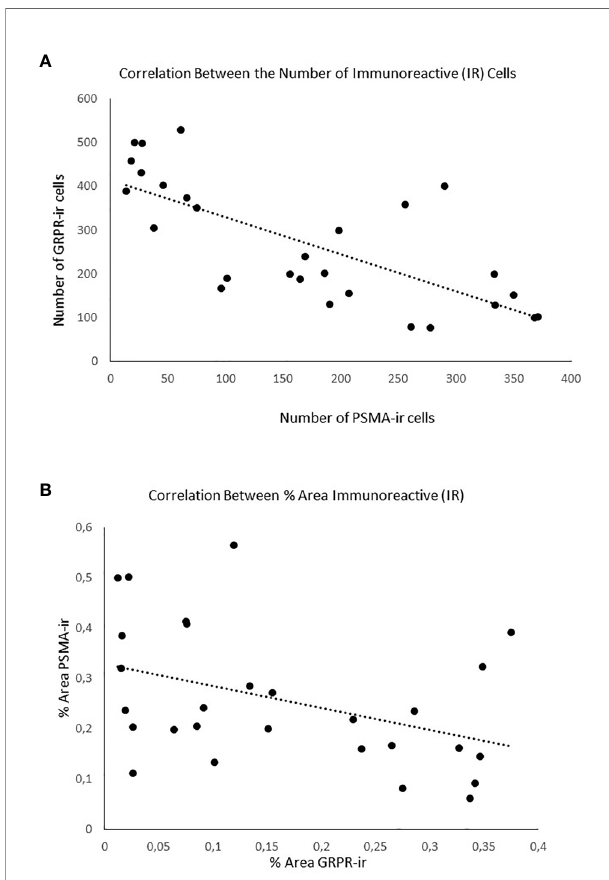
FIGURE 3 | Relationship between tumor grade, using Gleason scores, and expression of PSMA and GRPR. (A) the number of GRPR cells expressed (immunoreactive) was signi fi cantly higher in low grade tumors; (B) The % of area expressed was not signi fi cantly different by Grade for both markers. *p <